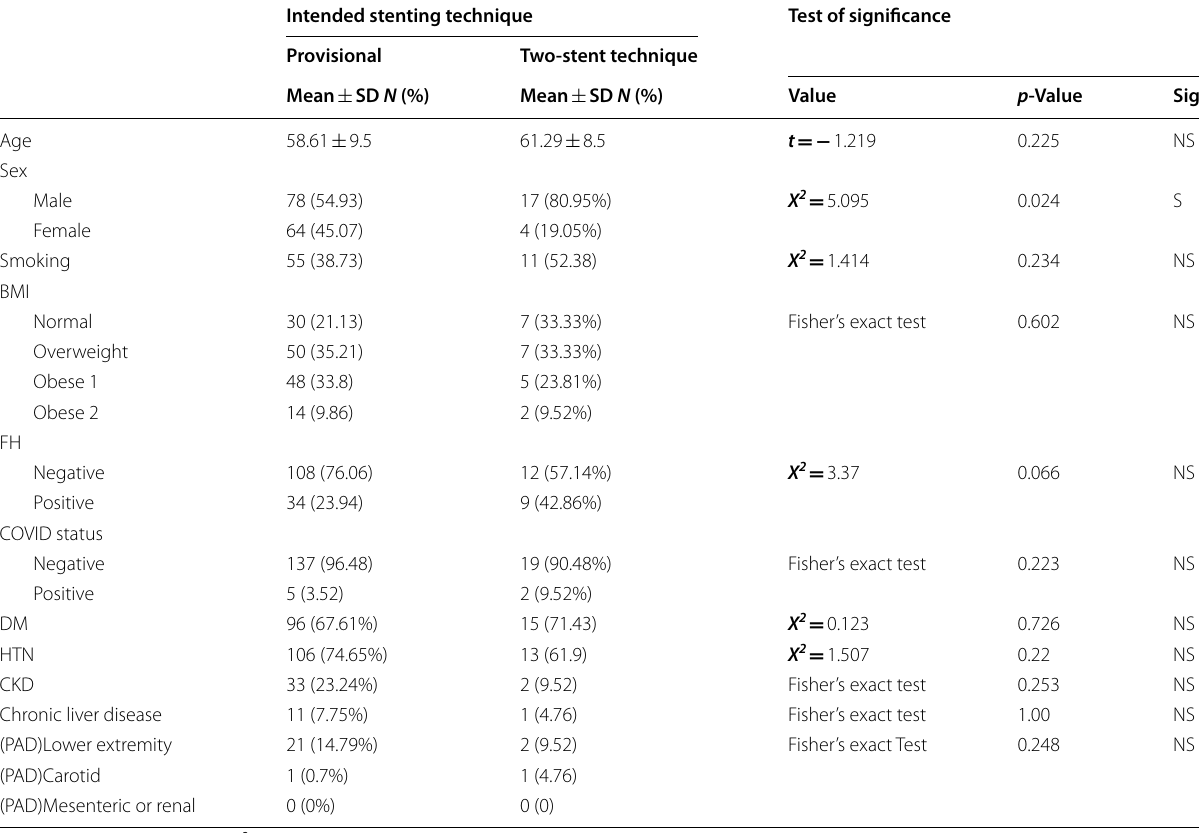
*Chi-square test of significance ( X 2